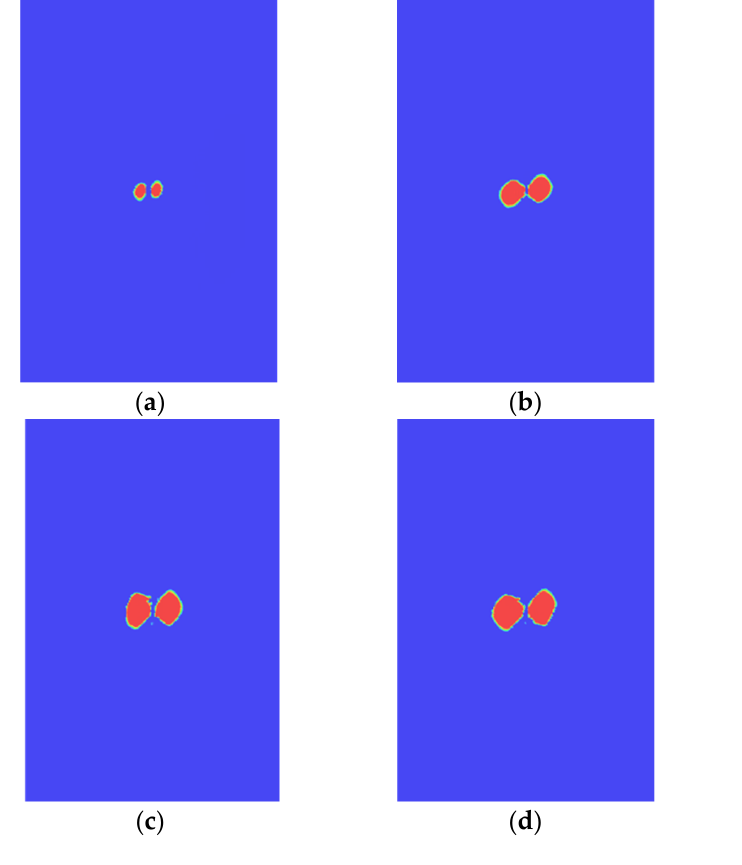
pact energy 20 J. ( c ) Impact energy 40 J. ( d ) Impact energy 50 J. energy 20 J. ( c ) Impact energy 40 J. ( d ) Impact energy 50